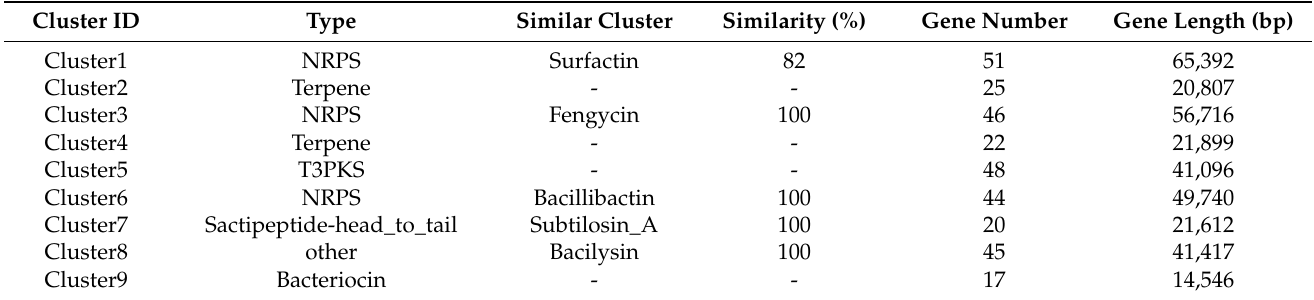
Table 6. Gene cluster analysis of the secondary metabolites of B. subtilis